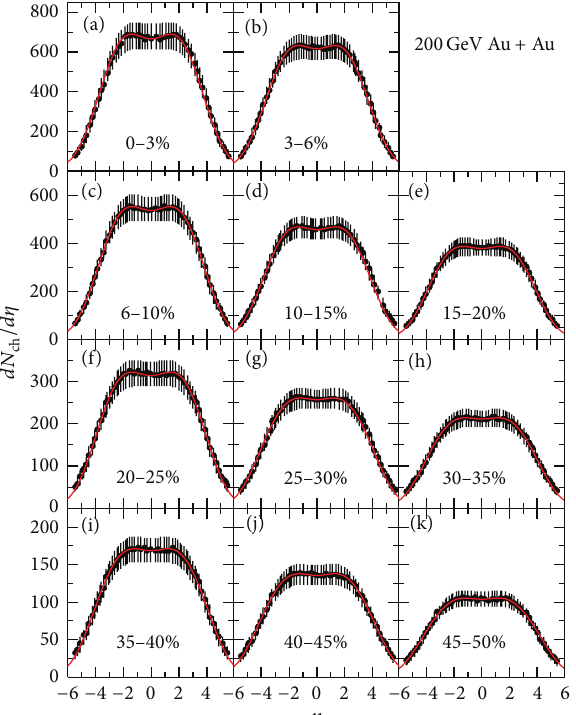
Figure 6: As Figure 1 but showing the results in Cu-Cu collisions at √𝑠 = 62.4 𝑁𝑁